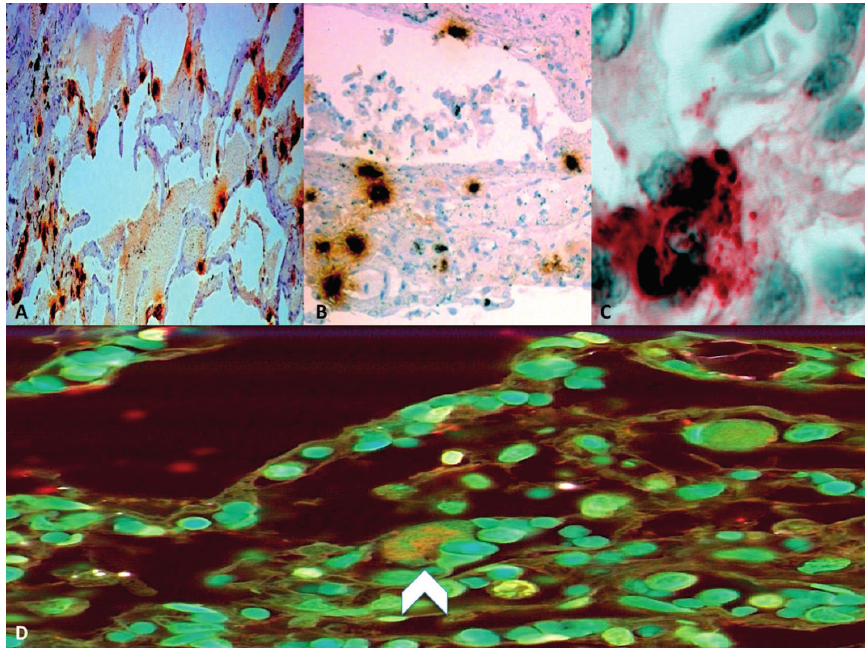
Figure 3. Histopatological findings. ( A ) Pulmonary mast cells with anti-tryptase reactions; ( B ) Degranulating mast cells mast cells present in a bronchial wall (Ab anti-tryptase); ( C ) Evidence of degranulating mastcells with tryptase-positive material outside the cells (Ab anti-tryptase); ( D ) Confocal laser scanning microscope: weak expression (head-arrow) of complement C3a in an AFE case. Figures extracted from cases previously published by Fineschi et al.